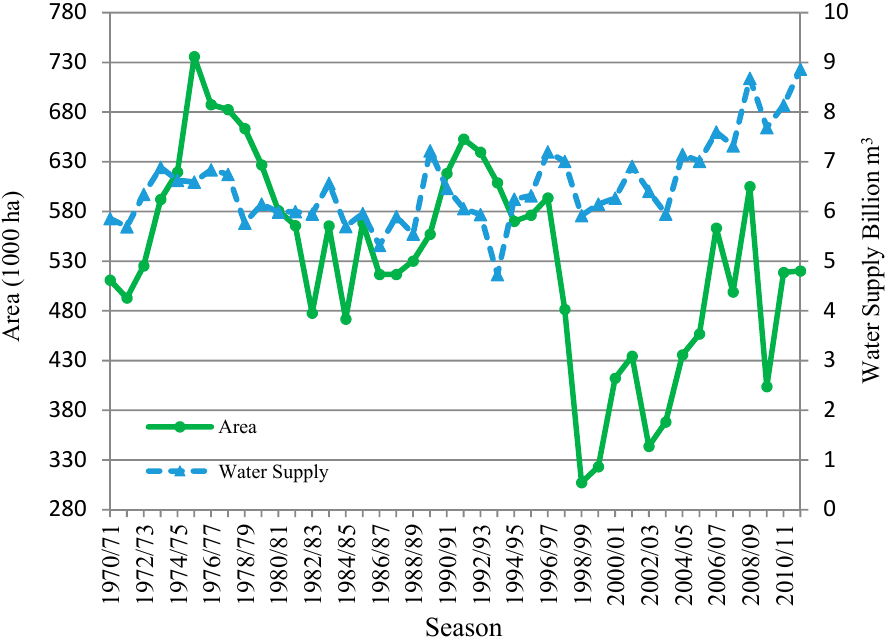
Figure 3. Variations in seasonal water supply and cultivated area.